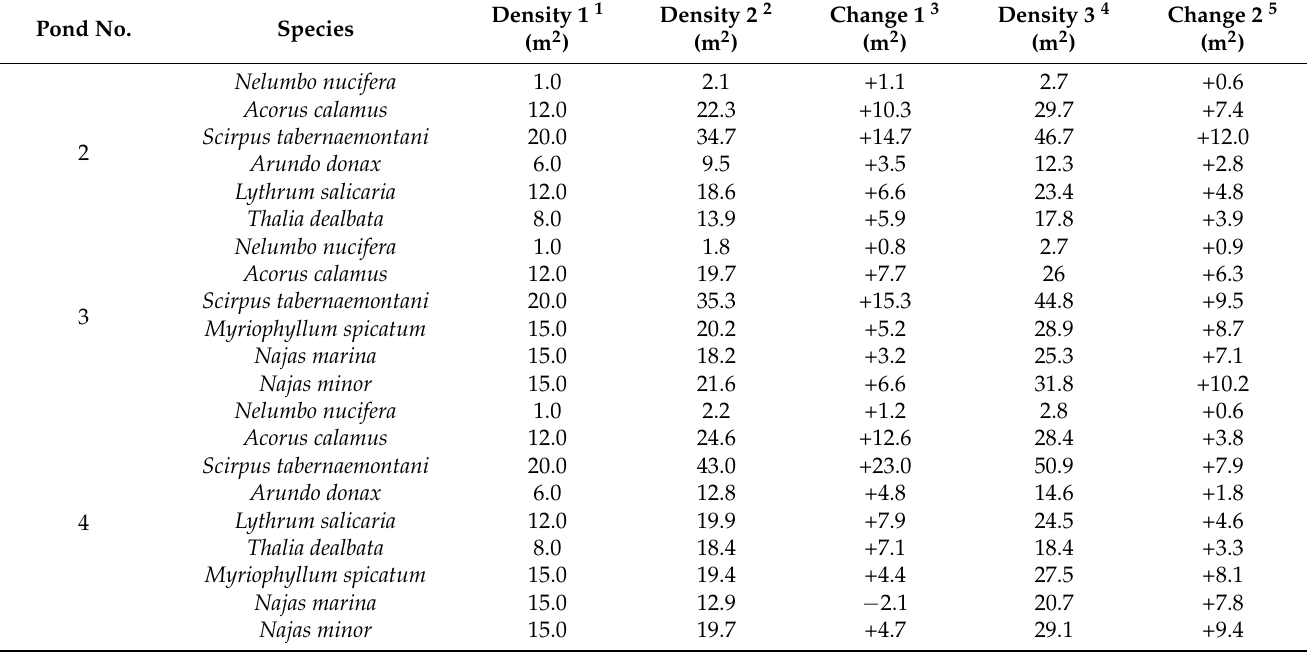
Table 4. Planting density and density change of aquatic macrophytes in the second and third experimental